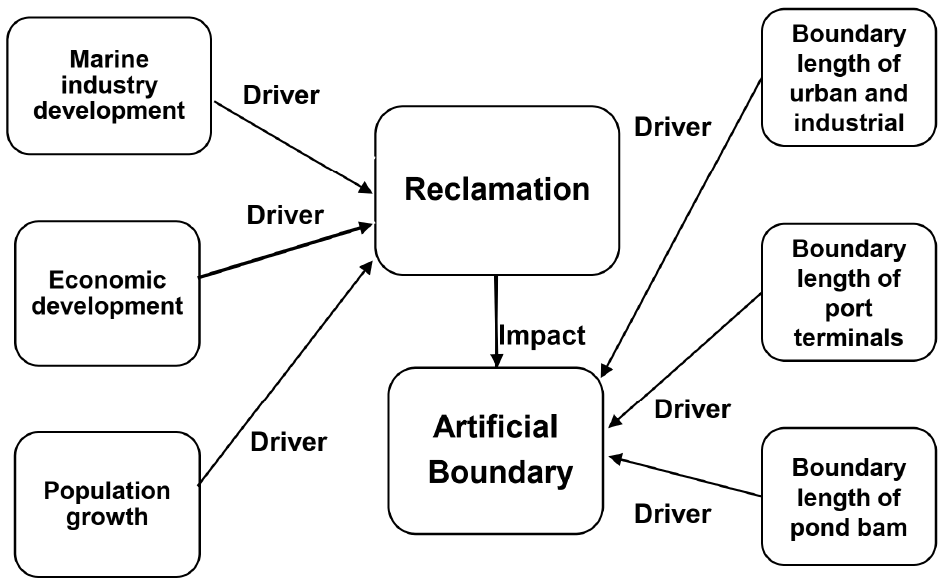
Figure 5. The expected model of causal factors upfront.